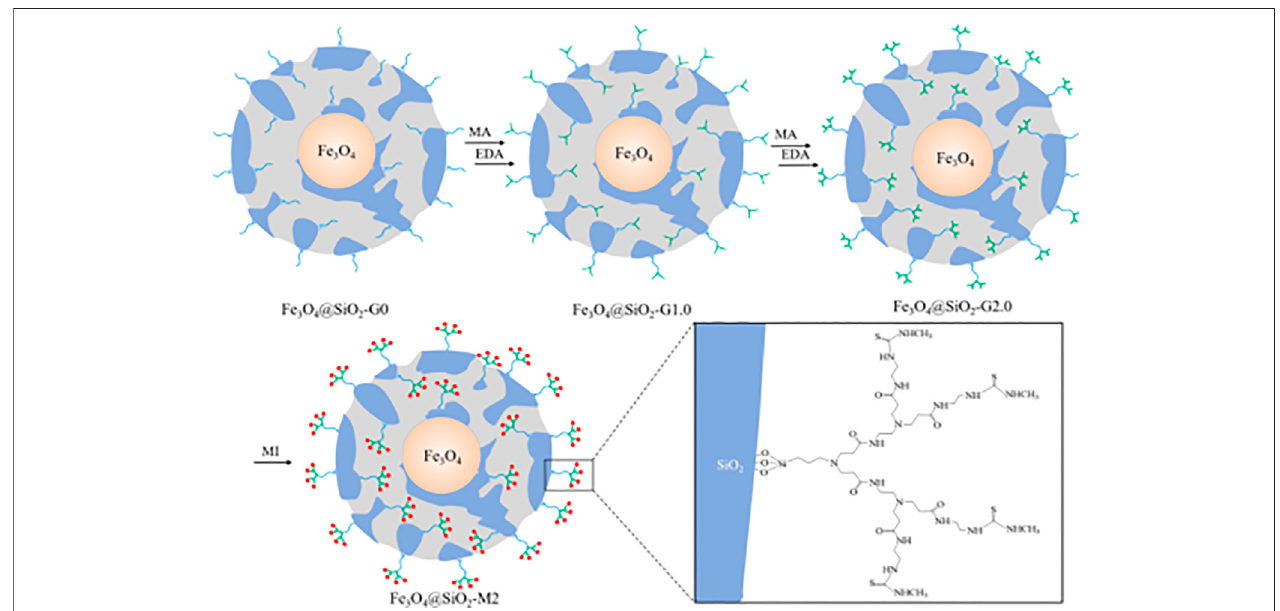
FIGURE 4 | The synthetic procedures for Fe 3 O 4 @SiO 2 -M2.